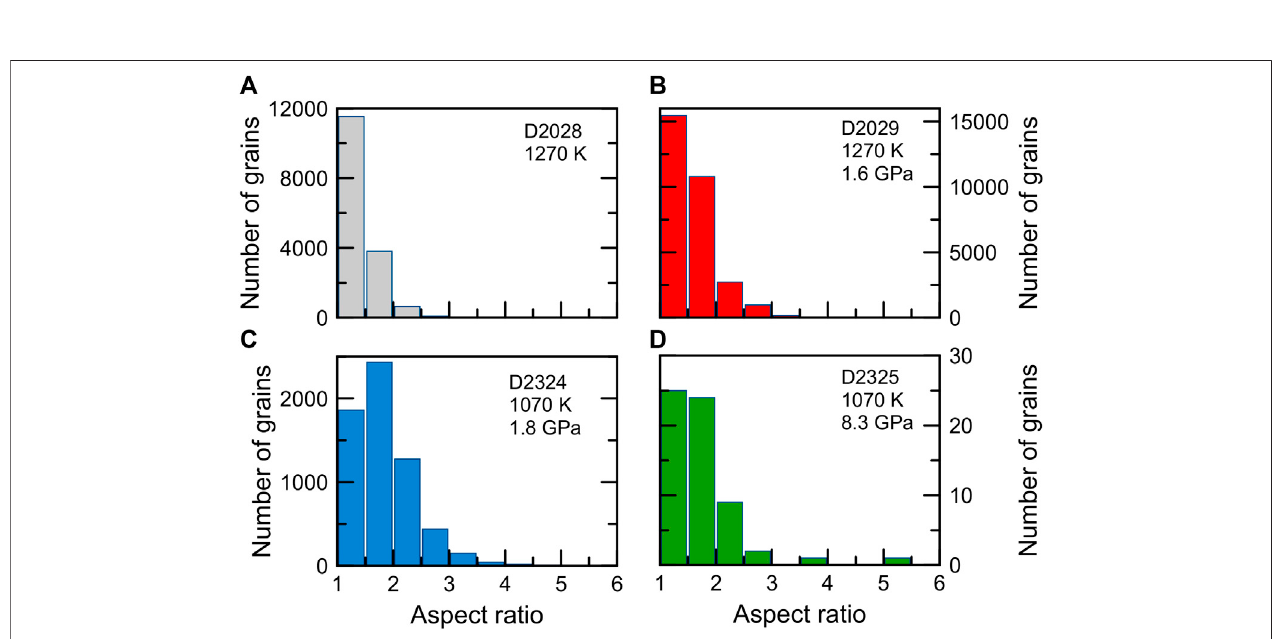
FIGURE7| Aspectratiodistributions. (A) Nondeformedsampleannealedathightemperature. (B) Samplesdeformedathightemperature. (C) Samplesdeformed under moderate temperature. (D) Sample deformed at high pressure. Note that these distributions were extracted over a broader area than that shown in Figure 8 .